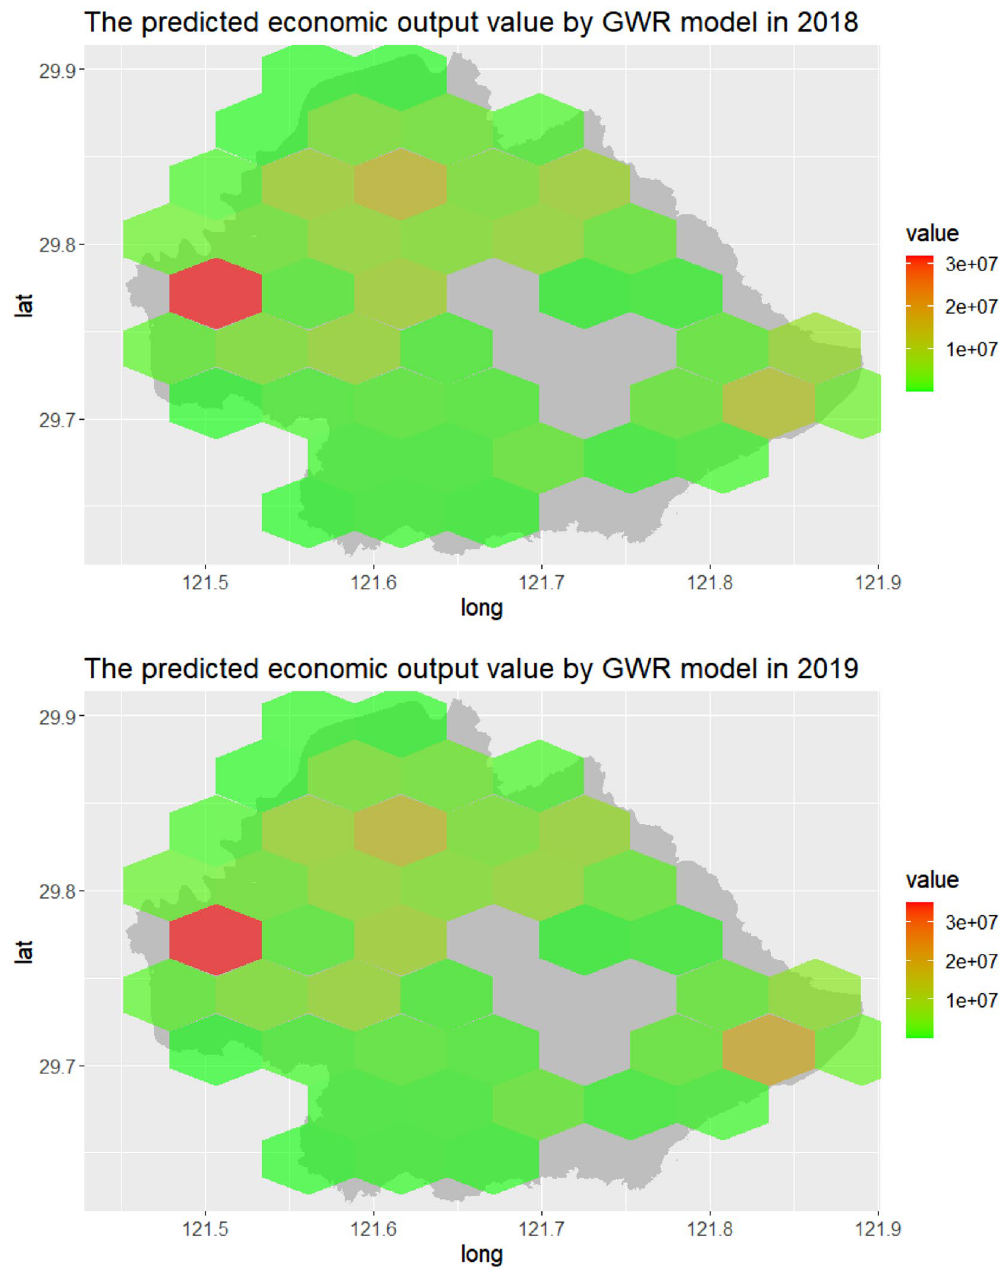
Figure 3. The spatial distribution of the annual economic output value based on the number of yearly positive online news using trained GWR model in Yinzhou,